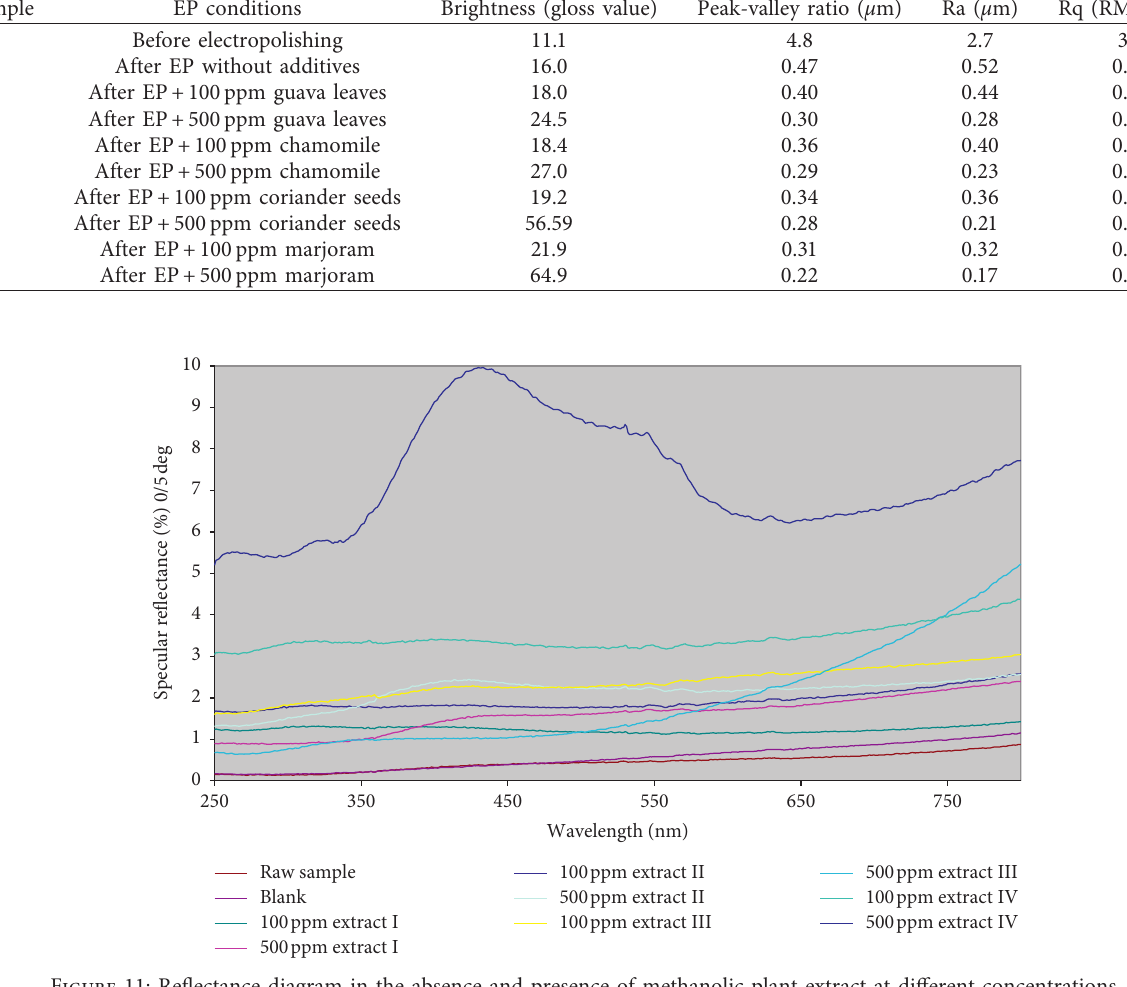
Figure 11: Reflectance diagram in the absence and presence of methanolic plant extract at different